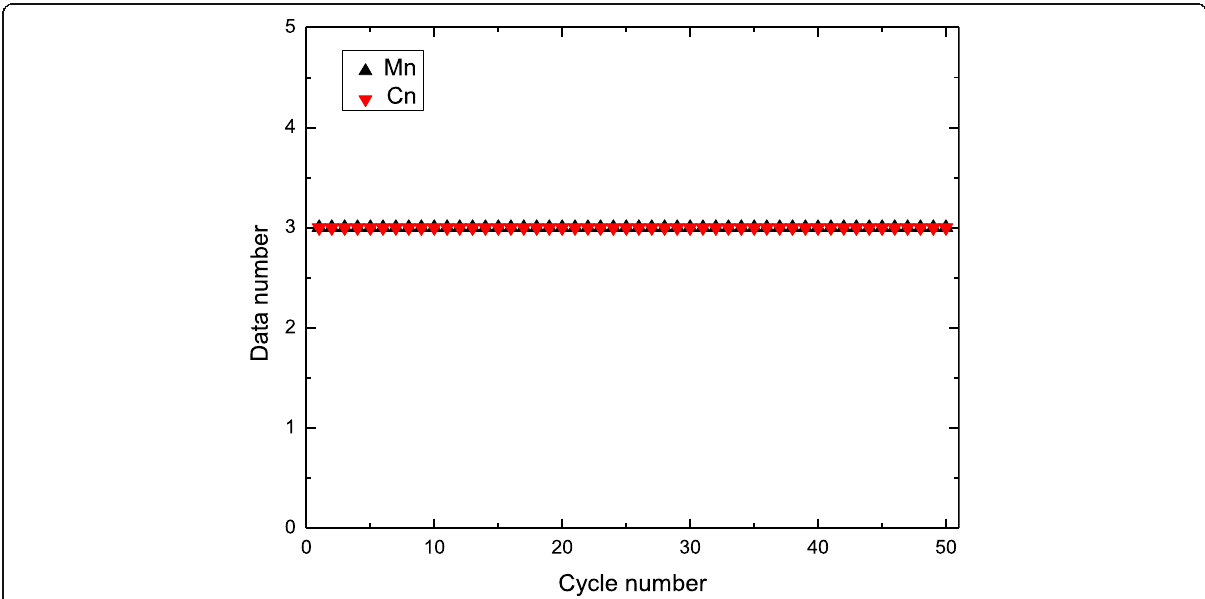
Fig. 25 The total volume of data is equal to 3 in each cycle; Mn and Cn in the first 50 cycles